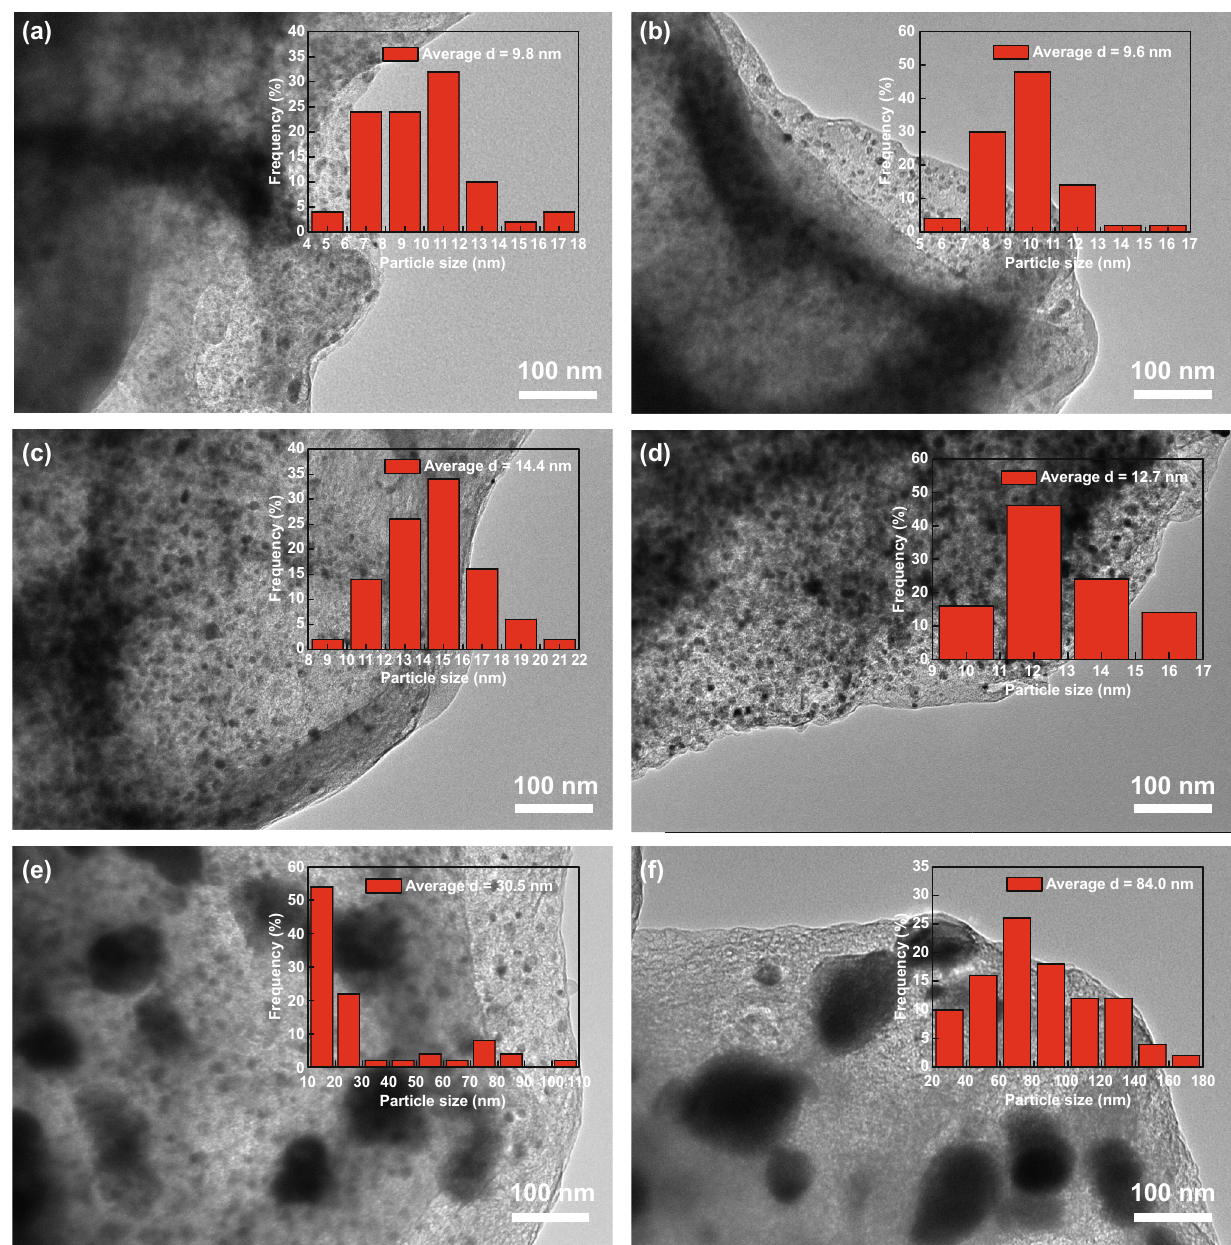
Fig. 4 TEM images of the samples obtained at different carbonization temperature: a 500 °C, b 600 °C, c 700 °C, d 800 °C, e 900 °C, and f 1000 °C (Insets are the size distributions of metal